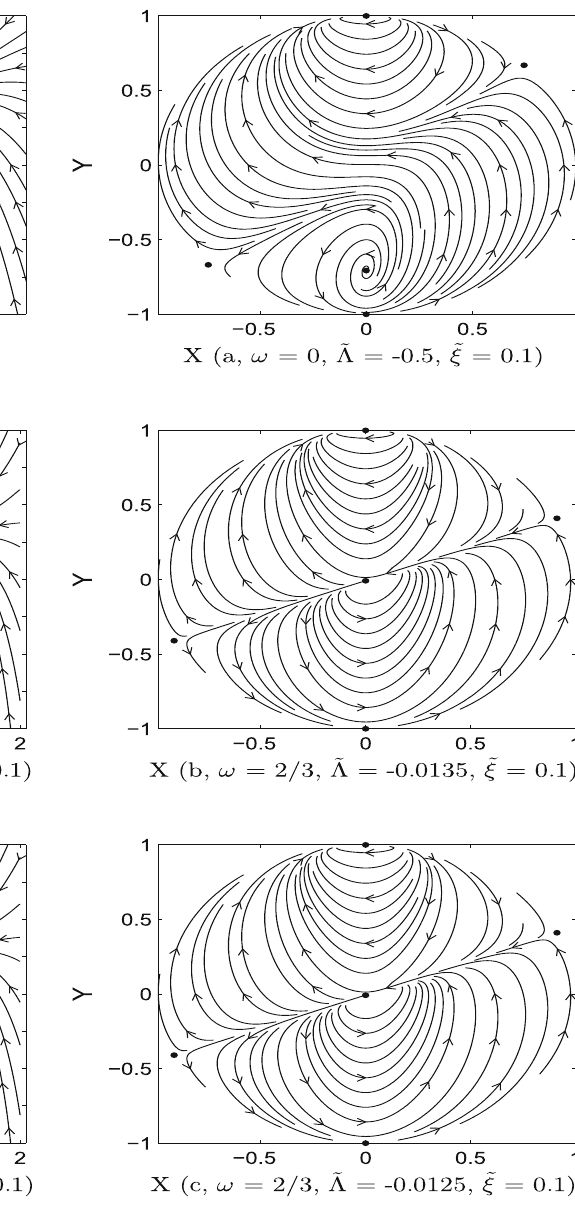
Fig. 11 Uncompact (left panel) and compact (right panel) phase less ˜ H and ˜ ρ as defined in Eq. (7). X and Y are the coordinates on portraits when viscosity is included, ˜ ξ = 0 . 1. Representa- the Poincaré sphere as defined in Eq. (47). The dotted circles represent (cid:11) (cid:12) (cid:11) (cid:12) fixed points ω = 0 , ˜ (cid:4) = − 0 . 5 ω = 2 , ˜ (cid:4) = − 0 . 0135 tive cases are , and 3 (cid:12) (cid:11) , ˜ (cid:4) = − 0 . 0125 ω = 2 . x 1 and x 2 respectively denote the dimension- 3